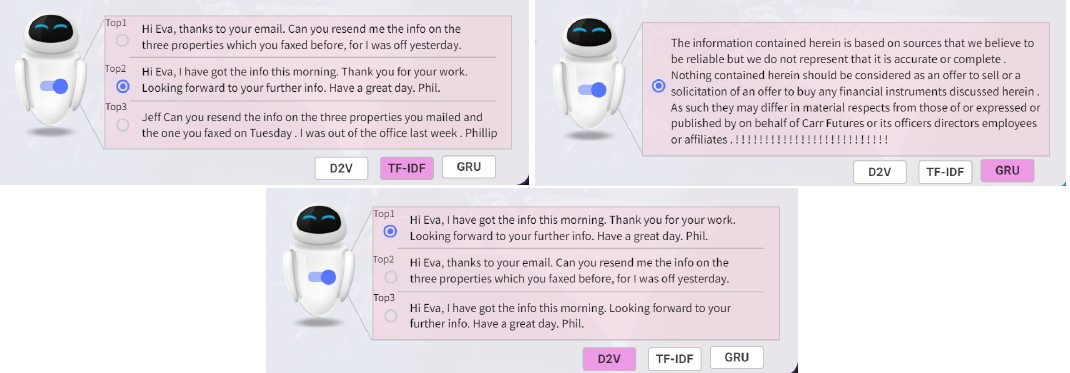
Figure 11. Three Models Results (The new received Email is: “Hi Phil, I am willing to get info. of two